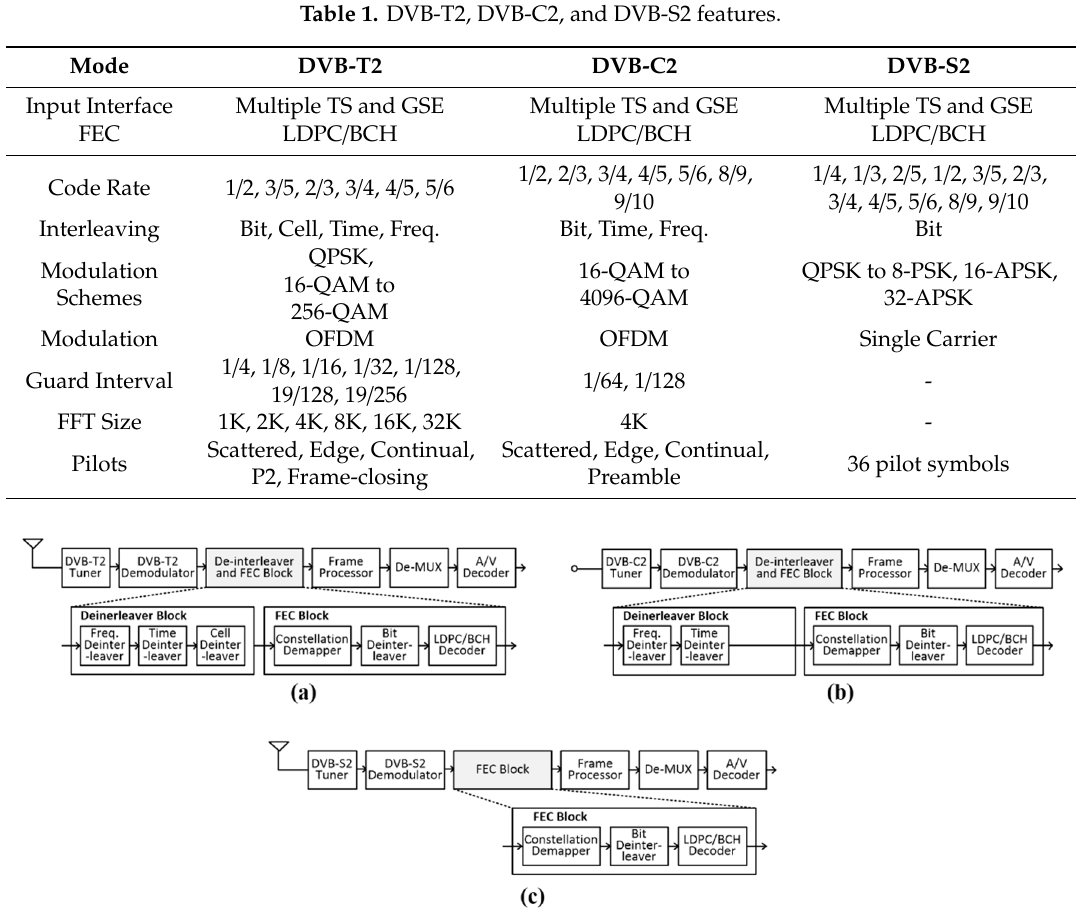
Figure 1. Block diagrams of ( a ) DVB-T2, ( b ) DVB-C2, and ( c ) DVB-S2 receivers.